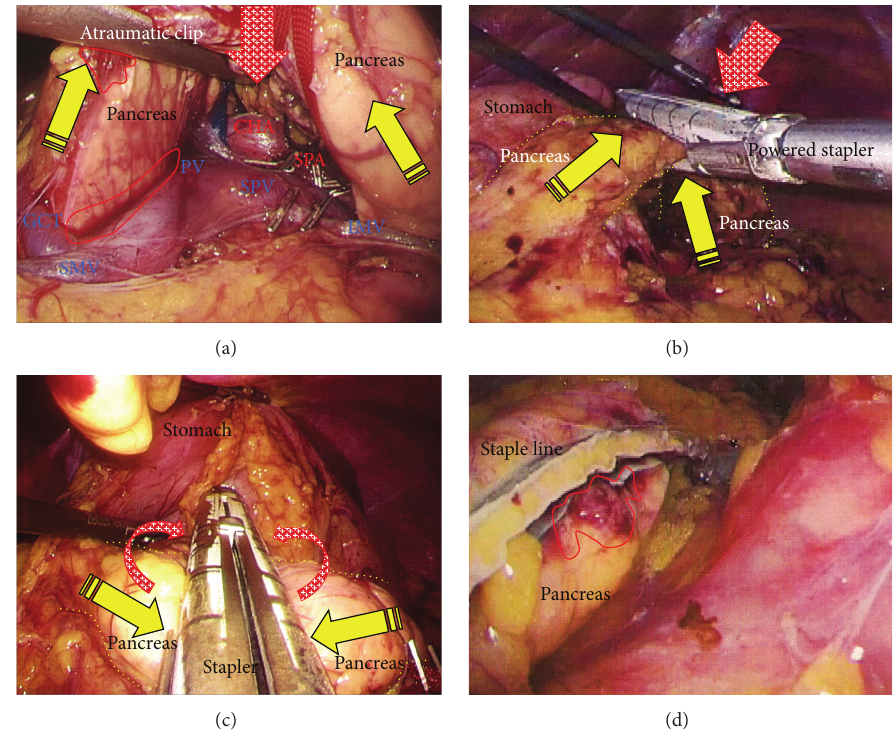
Figure 9: (a) Excess countertraction by the forceps and tape (yellow arrows) resulted in unexpected injury to the pancreatic parenchyma and capsule (red circles). Excess traction on the tape was released (red arrow). (b) Excess countertraction during stapling (yellow arrows) caused capsular injury near the staple line. Stapling should be performed as much to the dorsal side as possible to reduce excess countertraction (red arrow). A powered stapling system attenuates excess countertraction. (c) Excess tension when withdrawing during the stapler bite (yellow arrows) causes injury to the pancreatic parenchyma and membrane. All stapling procedures should be done at the correct position on the pancreas (red arrows). (d) Subtle injury to the capsule (red circle) should be never missed when evaluating the safety of pancreas